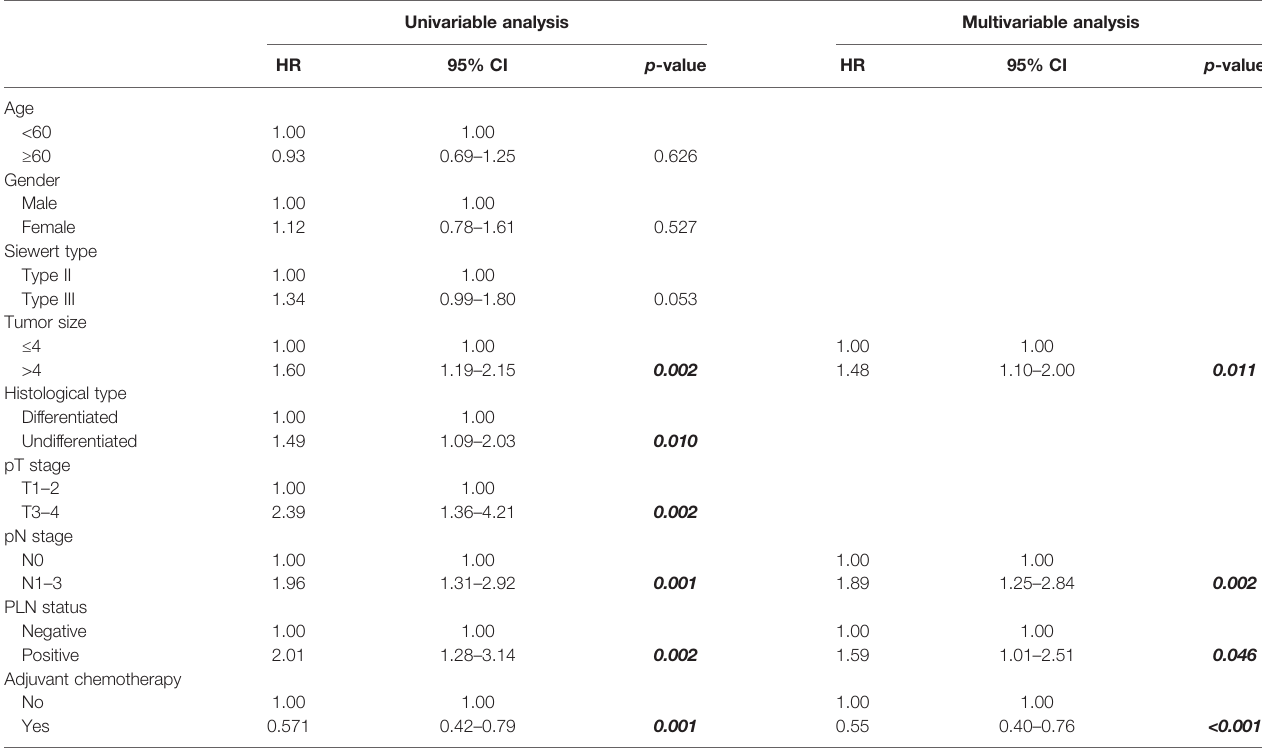
TABLE 2 | Univariable and multivariable analyses of 5-year OS in Siewert type II/III patients. Univariable